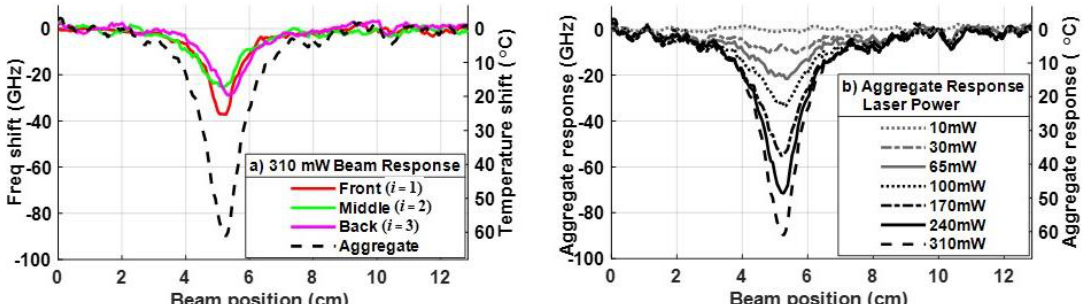
Figure 9. ( a ) Frequency (and temperature) shifts in the front, middle and back segments of the sensor for an optical power of 310 mW (as plotted in Figure 8), along with the aggregate response. ( b ) Amplified aggregate responses based on the measured temperature shifts at all seven optical power levels of the laser diode.